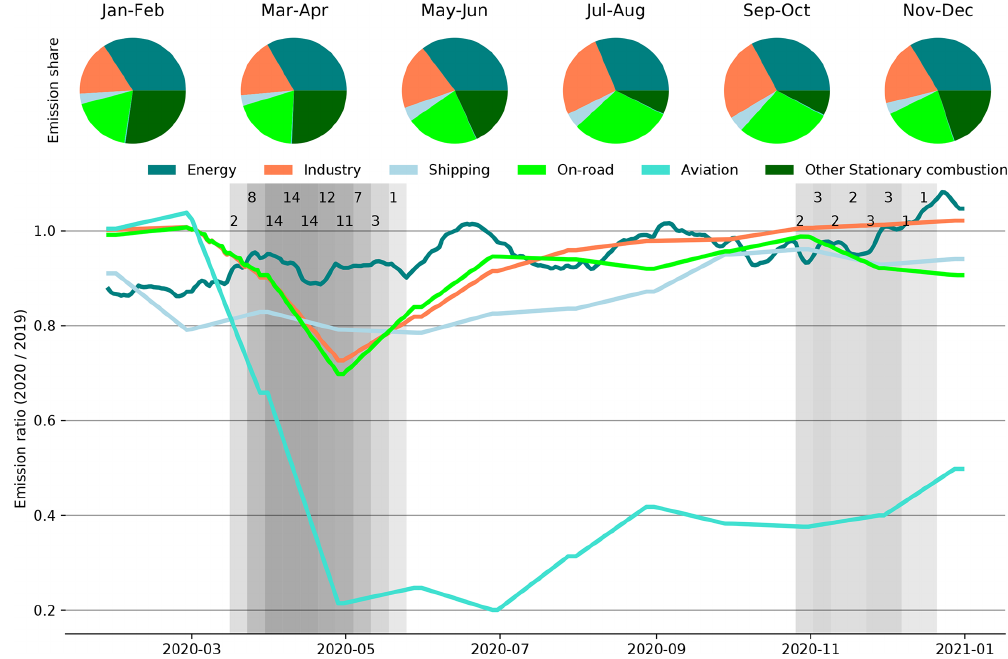
Figure 6. The relative sector share to total emissions in 2020 for 2-month periods is shown in the pie charts. Relative emissions compared to 2019 per sector calculated by a 28d rolling average are shown in the line graph. The grey shading indicates periods with lockdowns, and the number of European countries (out of 30) in lockdown as given by ECDC (2021) is indicated by the number in the grey bar. Household emissions are not included in the lower panel, as household emissions only respond to temperature here. Note that aviation has a relatively small share, as we only include emissions during landing and takeoff, following GNFR sector definitions.